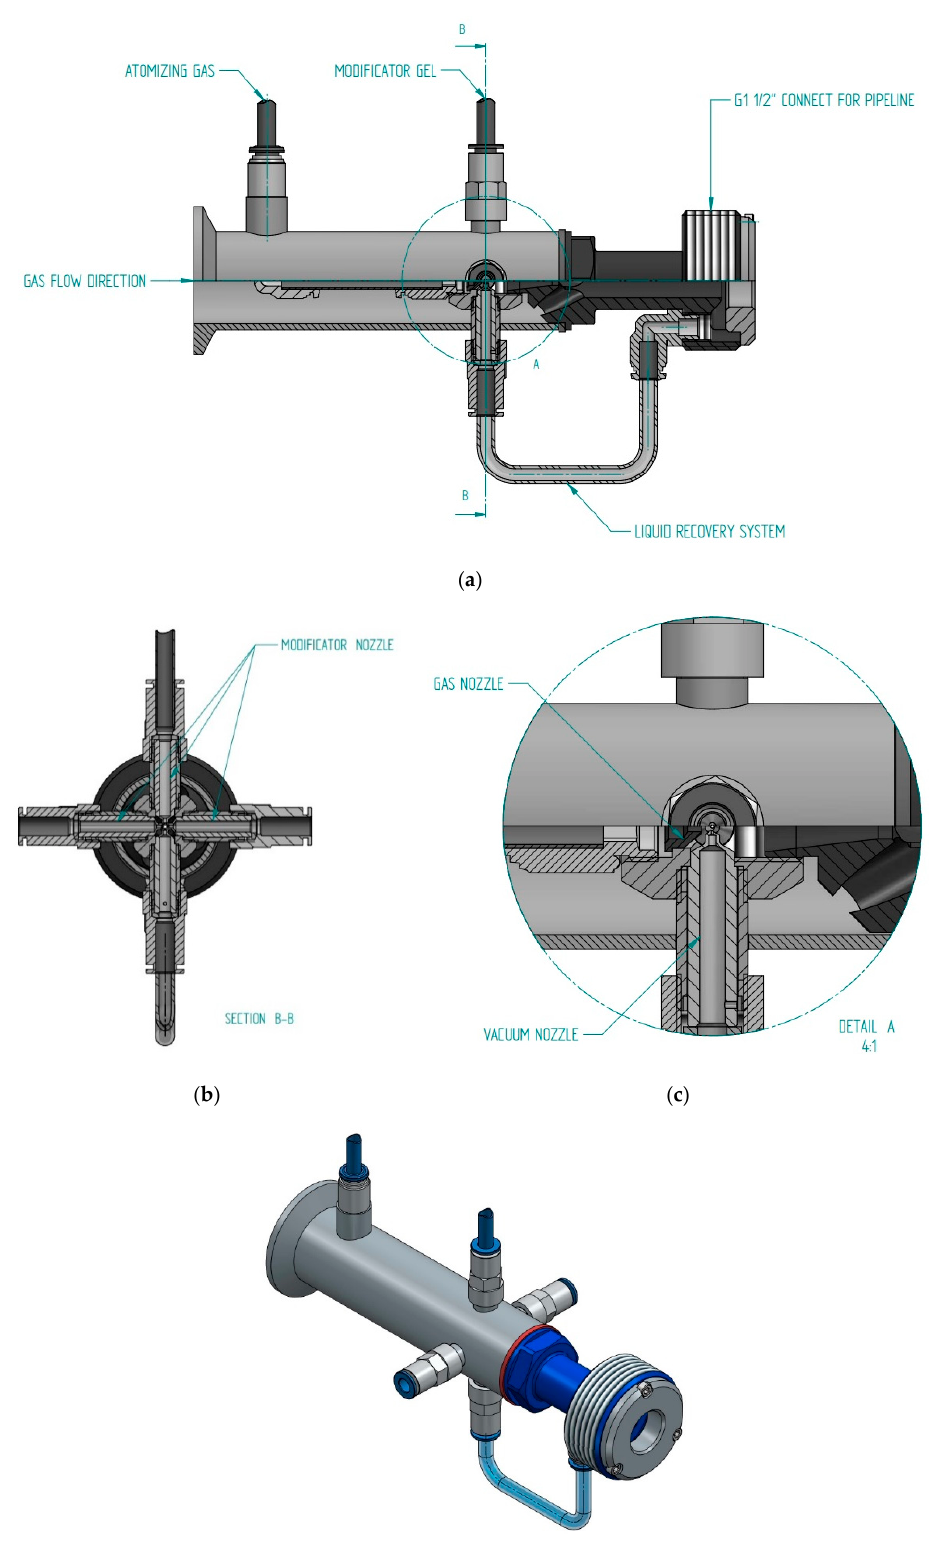
Figure 1. Test stand.